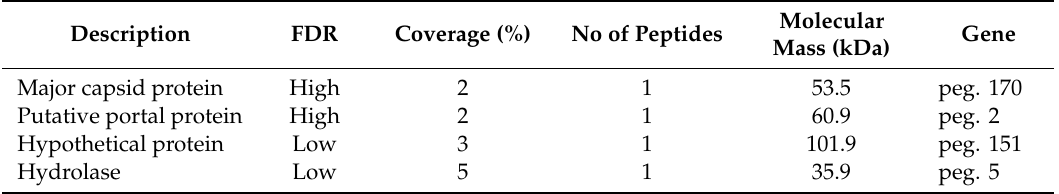
Table 3. Mass spectrometry data for virion-associated proteins of phage